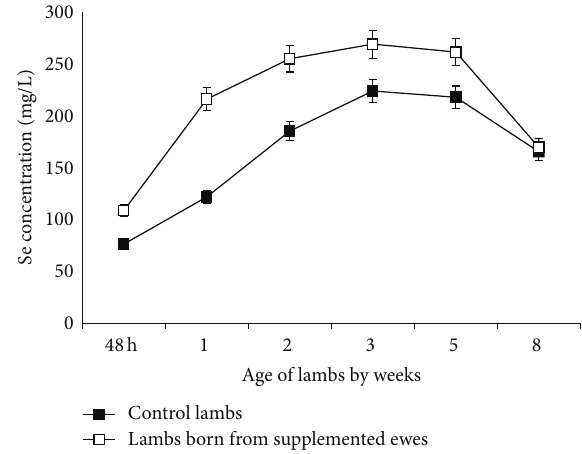
Figure 2: Plasma Se concentrations (mean ± SEM) of newborn lambs from Se supplemented and control ewes.